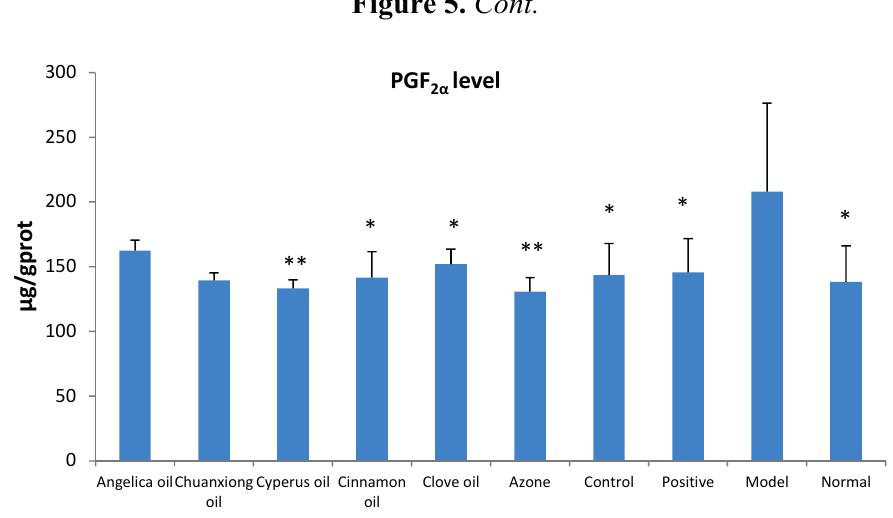
Figure 5. Effects of ibuprofen (140 mg/kg/day) with different EOs on the levels of calcium ion, nitric oxide and PGF 2 α in uterine tissue of dysmenorrheal model mice (n = 8).